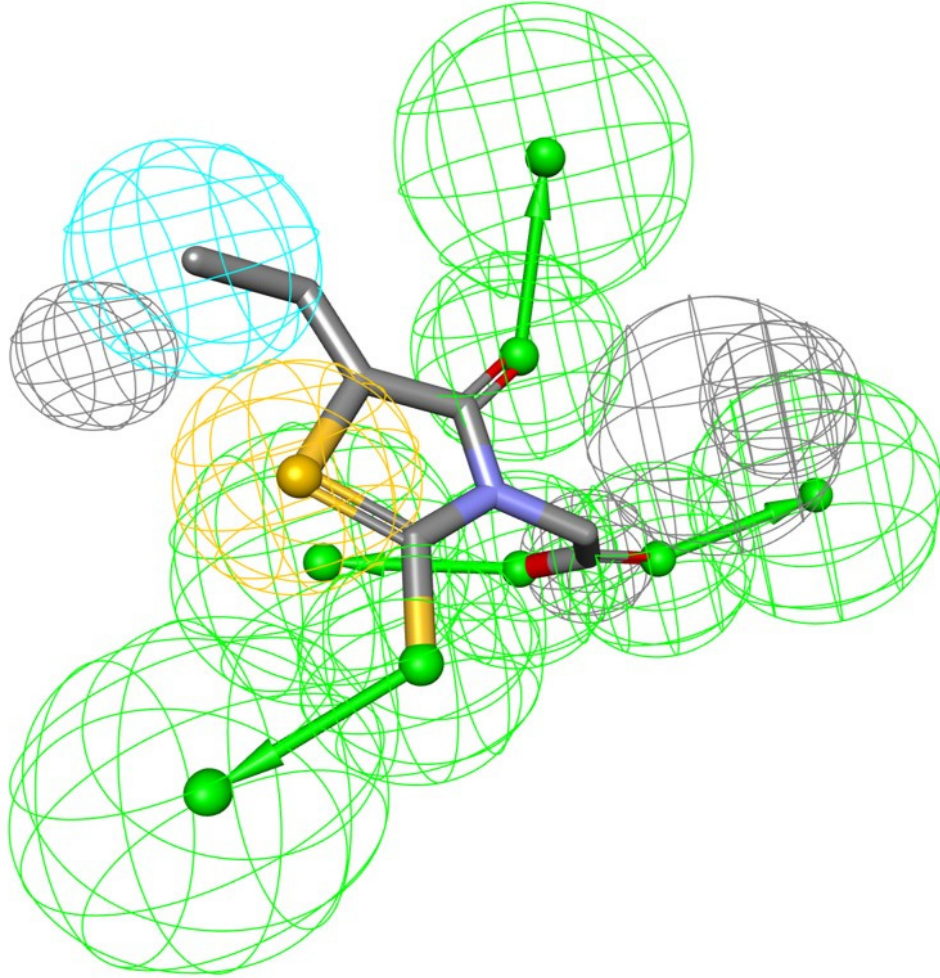
Figure 1. Generated pharmacophore model exploiting eplarestat.